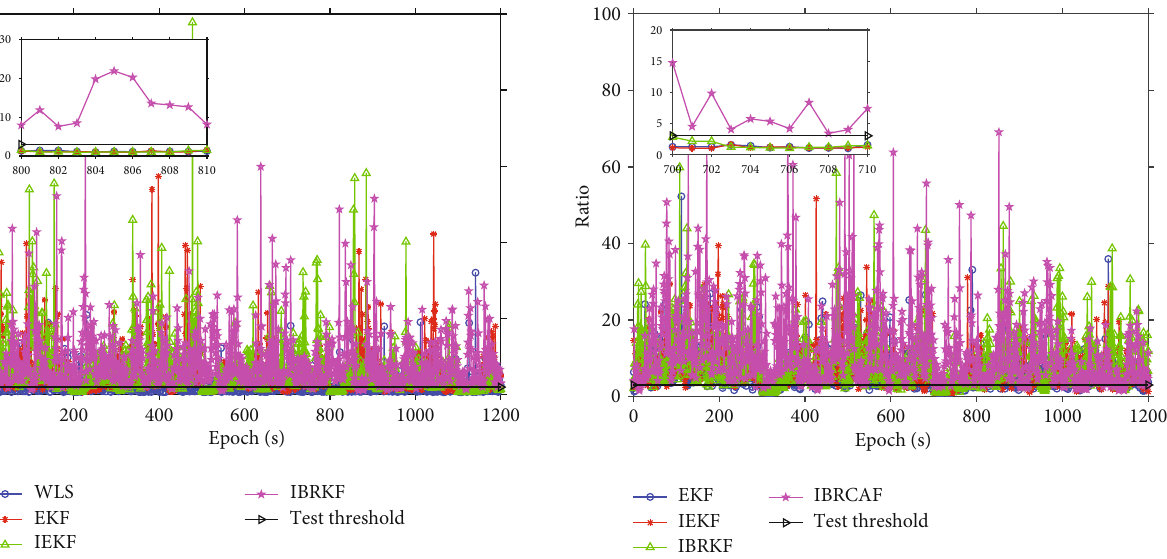
Figure 11: The ratio values of EKF, IEKF, IBRKF, and IBRCAF (Data 4).